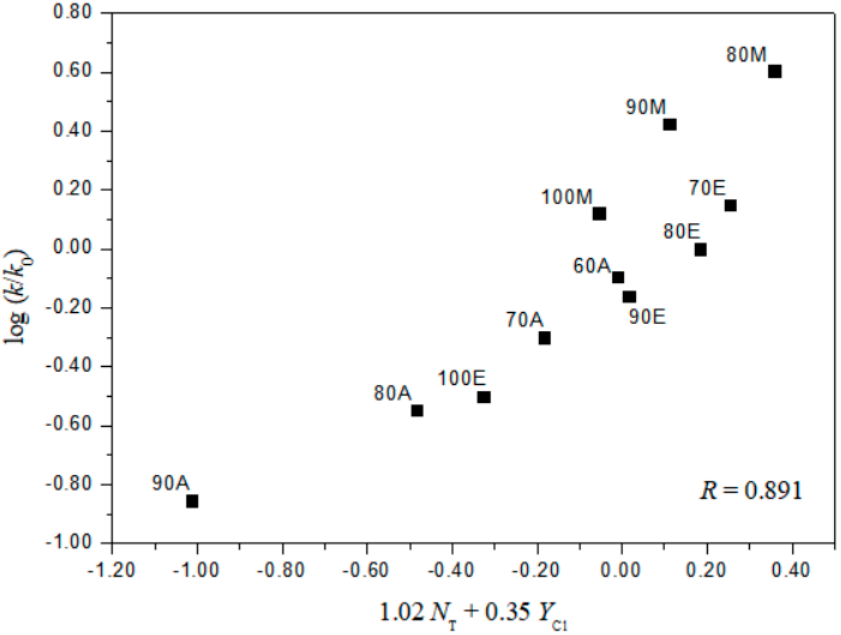
Figure 4. The plot of log ( k / k o ) o vs. 1.02 N T + 0.35 Y Cl for the solvolysis of o -nitrobenzoyl chloride ( 2 ) in various organic solvents except all fluoroalcohol solvents at 25.0 ◦ C.